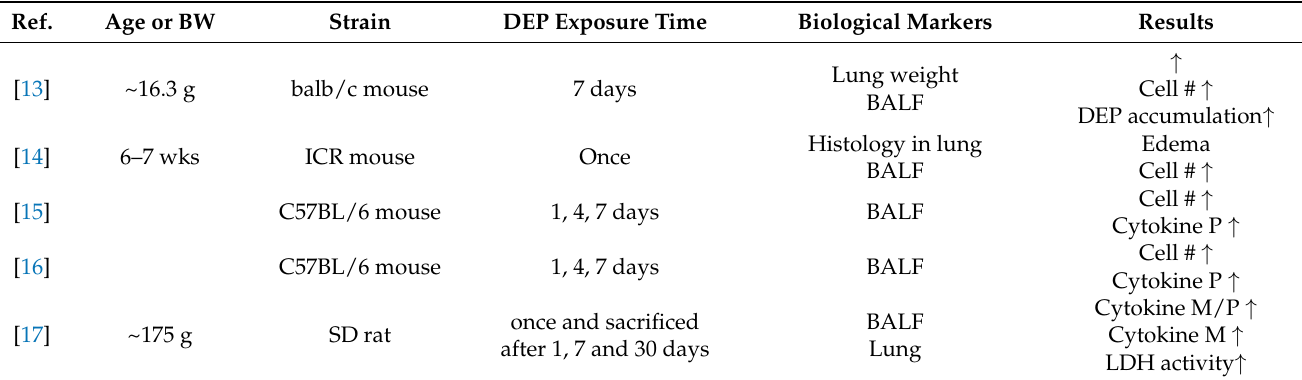
Table 2. Selected studies of diesel exhaust particles